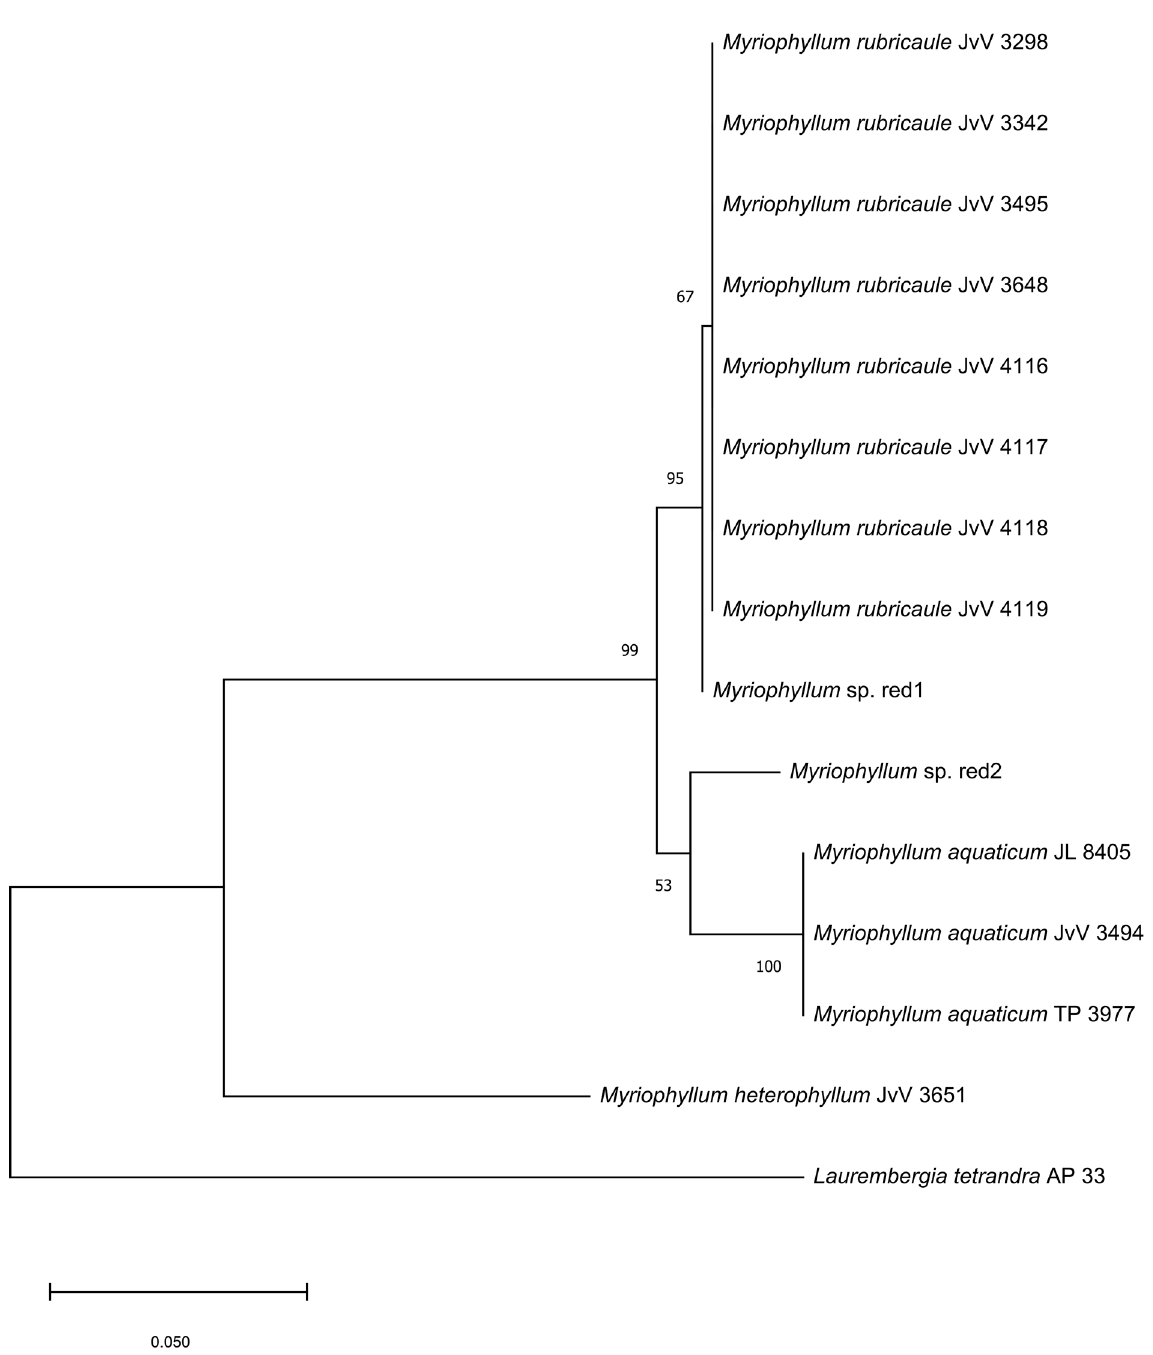
Fig. 2. Maximum likelihood tree based on ITS (partial 18S, ITS1, 5.8S, ITS2, partial 28S) sequences. The Tamura 3 parameter model was used (Tamura 1992). The tree with the highest log likelihood (-1398.71) is shown. Bootstrap values after 1000 replicates are expressed as percentages. A discrete Gamma distribution was used to model evolutionary rate differences among sites (5 categories (+G, parameter = 0.4031)). The tree is drawn to scale, with branch lengths measured in the number of substitutions per site. Laurembergia tetrandra AP 33 was used as an